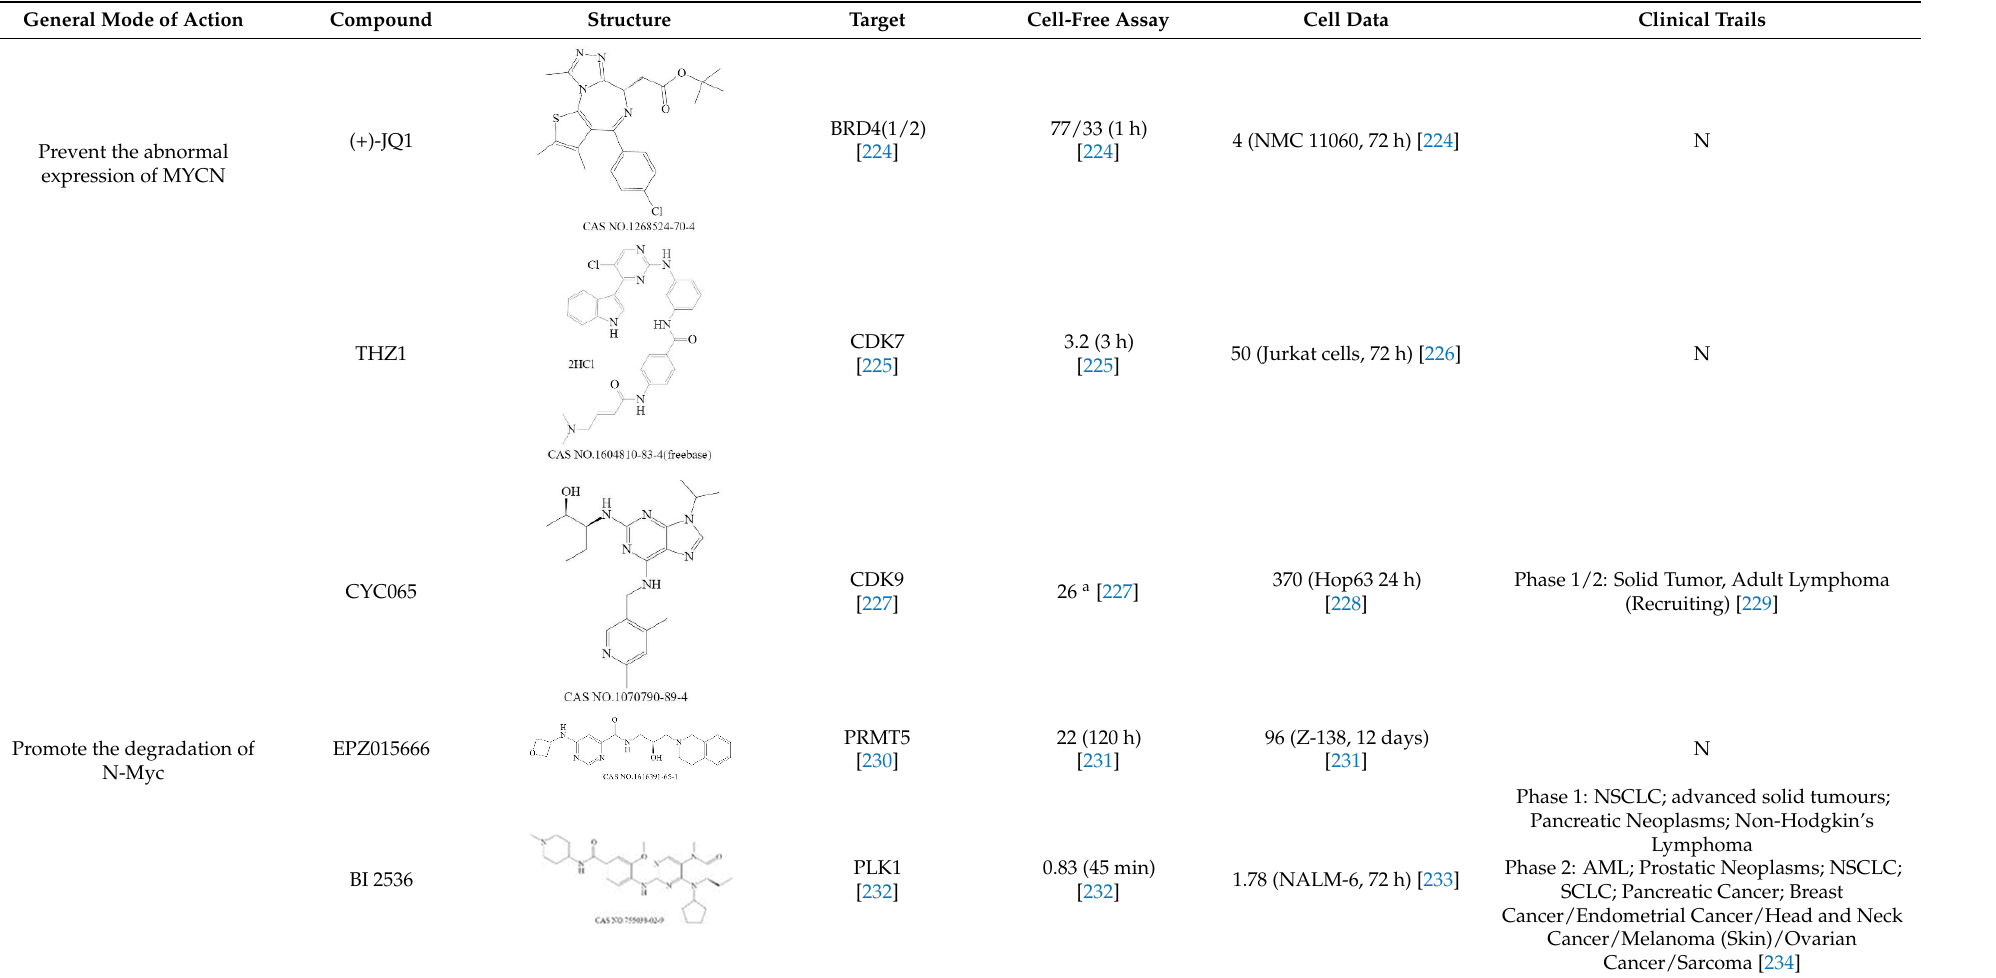
Table 2. Small-molecule compounds targeting N-MYC and its downstream.